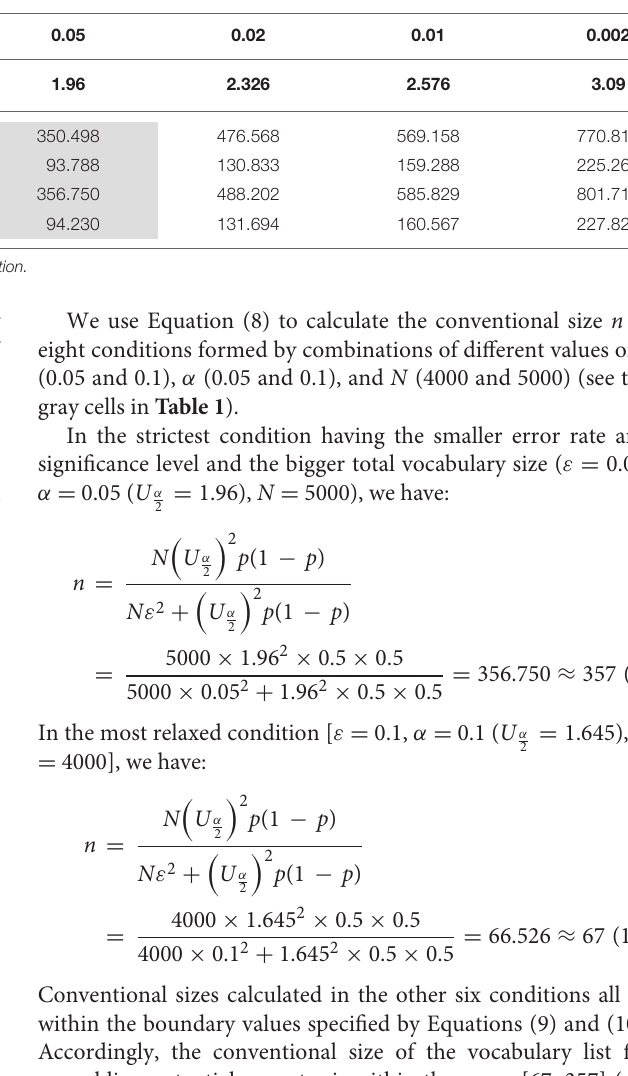
of the standard normal distribution at different significant level α , and the conventional sizes calculated using Equation (8) at error rate ε = TABLE 1 | U α 2 0.05 or 0.1 and total vocabulary size N = 4000 or